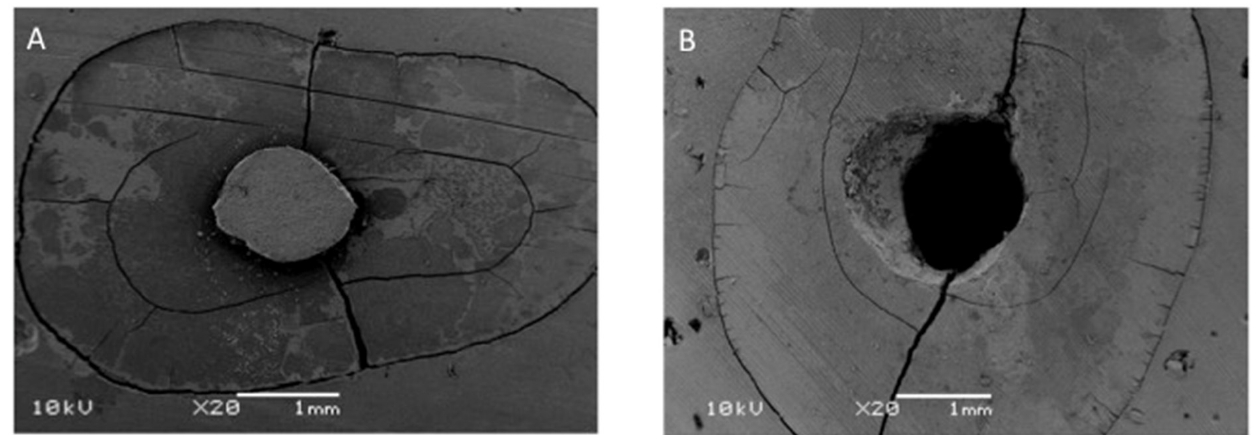
Figure 7. SEM analysis for Failure mode analysis. ( A ) Adhesive failure. ( B ) Mixed fail- ure.